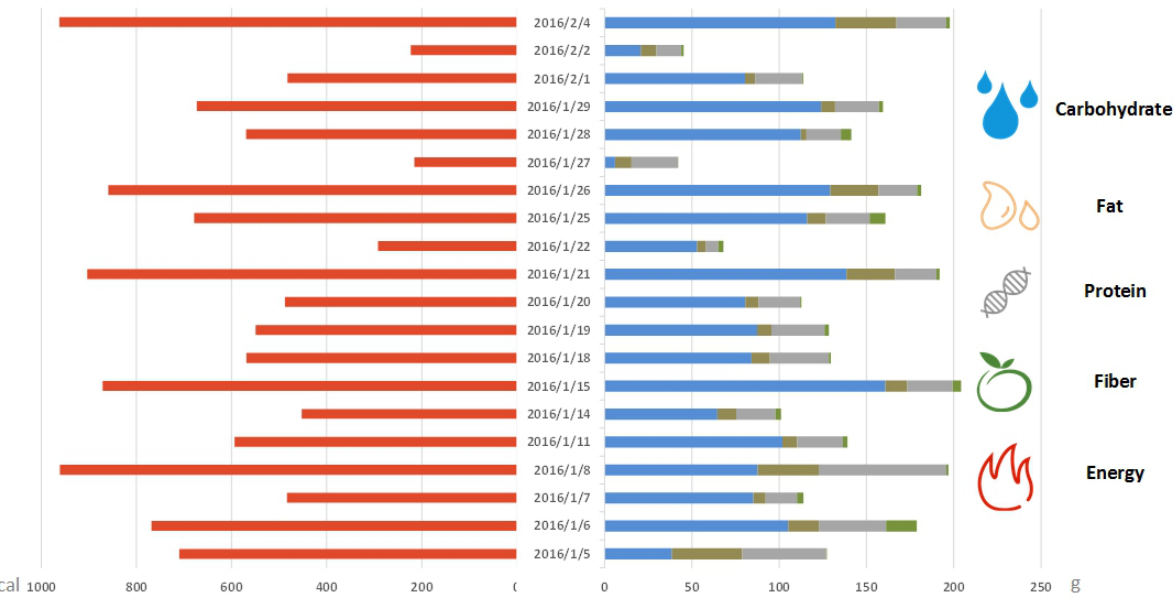
Figure 7. Example of system output: energy (left) and nutrient calculation results (right) for a sample individual. Blue: carbohydrate; orange: fat; gray: protein; green: fiber; red: energy